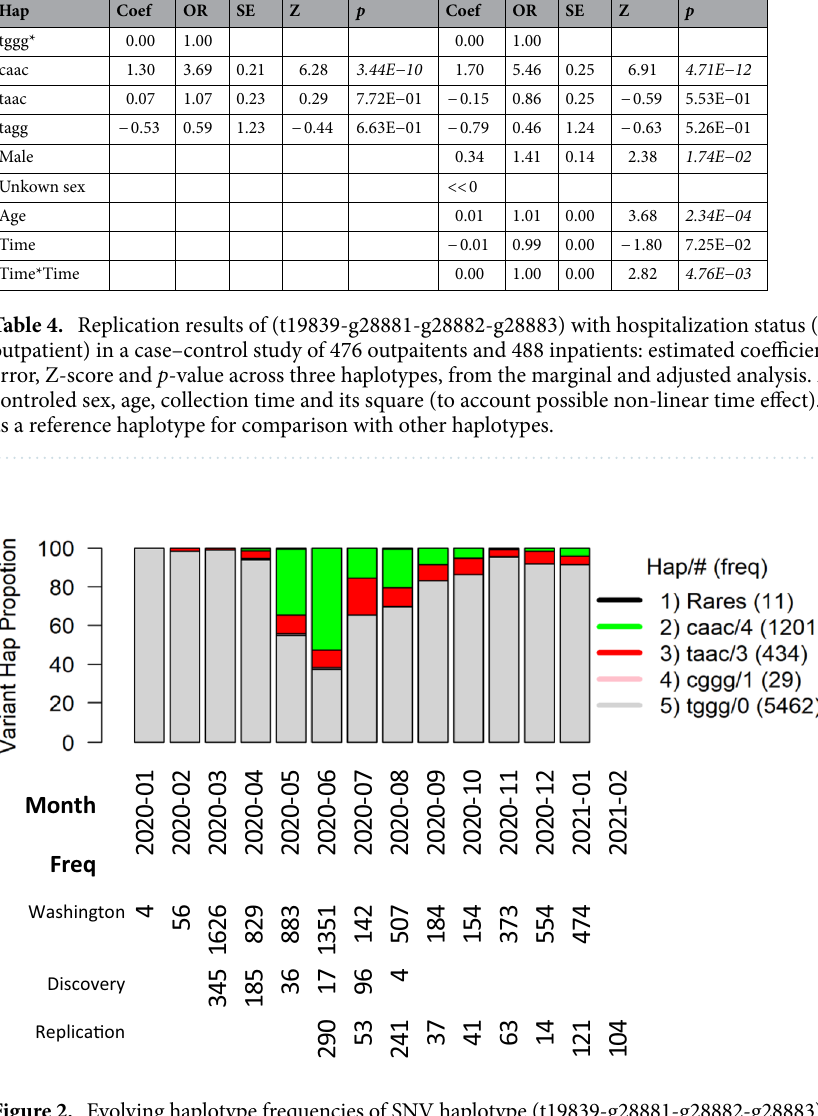
Figure 2. Evolving haplotype frequencies of SNV haplotype (t19839-g28881-g28882-g28883) over January 2020–2021 in Washington. Total number of samples sequenced in each month is placed below the plot. For convenience, patient numbers in discovery and replication cohorts are also included below the plot. Besides rare haplotypes, four haplotypes are annotated together with number of SNVs in each haplotype and haplotypic frequency in